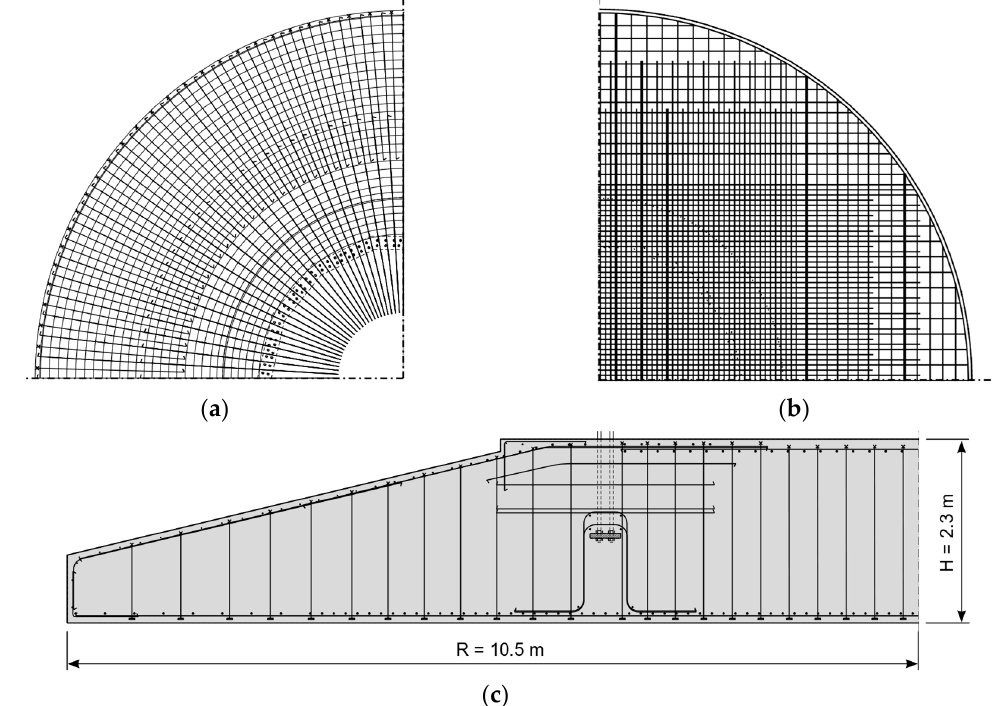
Figure 2. The studied reinforced concrete gravity-based foundation studied: ( a , b ) plan views of a quadrant of the foundation showing ( a ) the top reinforcement layout and ( b ) the bottom reinforcement layout; and ( c ) the radial section of the foundation.